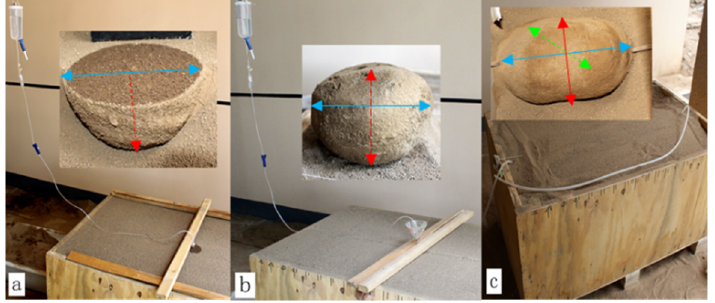
Figure 2. Real measurement configuration and excavation pictures of a SWB. ( a ) For a surface drip irrigation SWB (hemisphere); ( b ) for a subsurface bubbler irrigation SWB (sphere); ( c ) for a moistube irrigation SWB (circular cylinder). The length of the blue arrow represents the length of the SWB, while the red one represents the thickness of SWB. The green arrow represents the width of the moistube irrigation SWB, which goes through the intersection of the red and blue lines and is perpendicular to them.